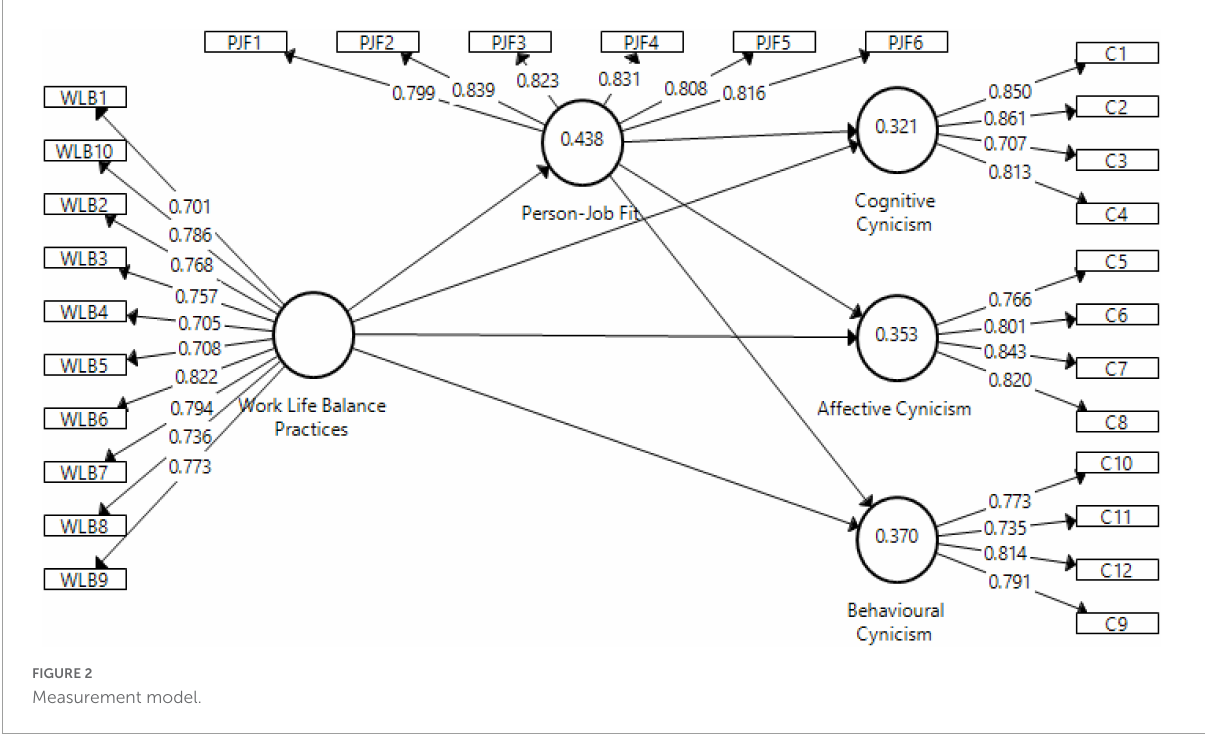
FIGURE2 Measurement model.